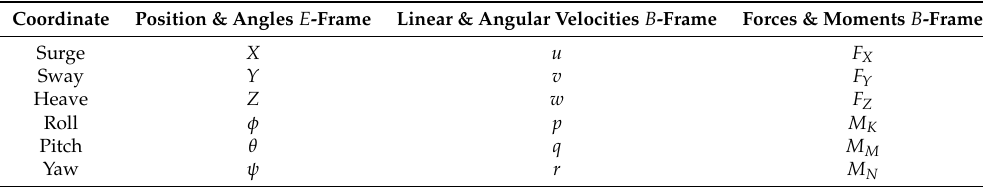
Figure 1. REMUS body frame and inertial reference frame. Table 1. Notations for Underwater